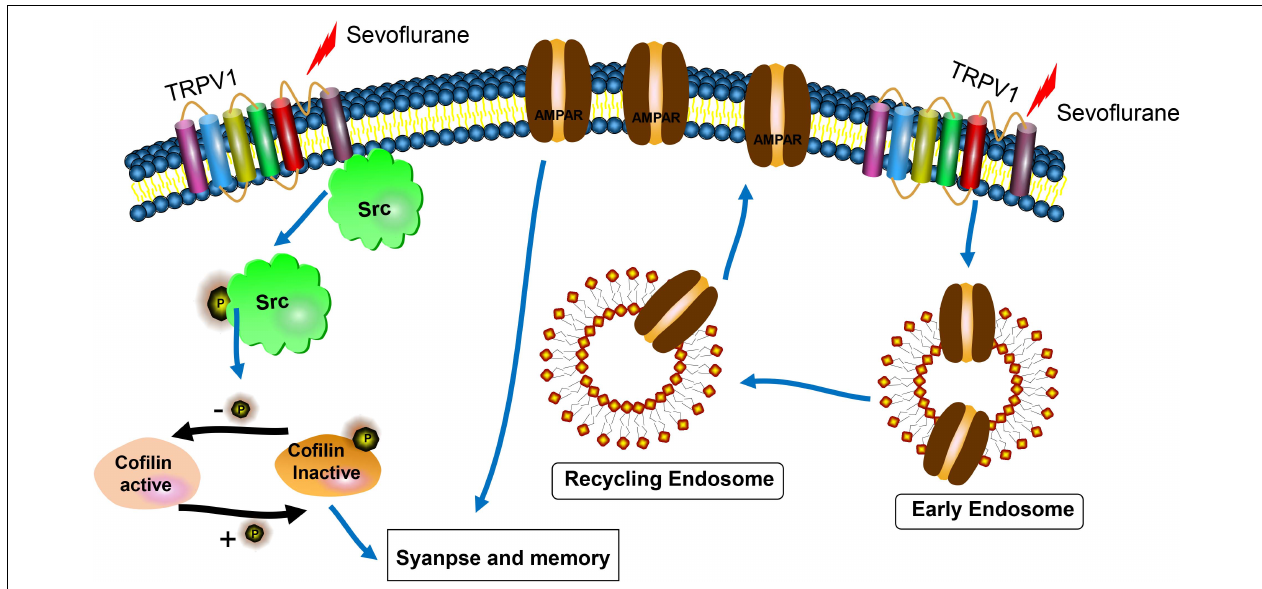
FIGURE 8 | Scheme for the proposed mechanisms of TRPV1 antagonist protection of synaptic loss and memory defects induced by sevoflurane exposure. The underlying mechanisms may be involved with the interactions of TRPV1 and Src, cofilin activation, and AMPAR trafficking deficiency.